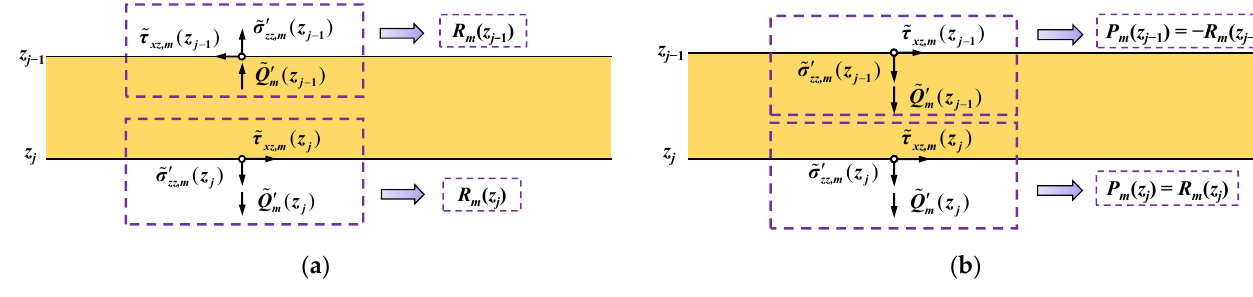
Figure 3. Positive stress directions in ( a ) local coordinates and ( b ) global coordinates.